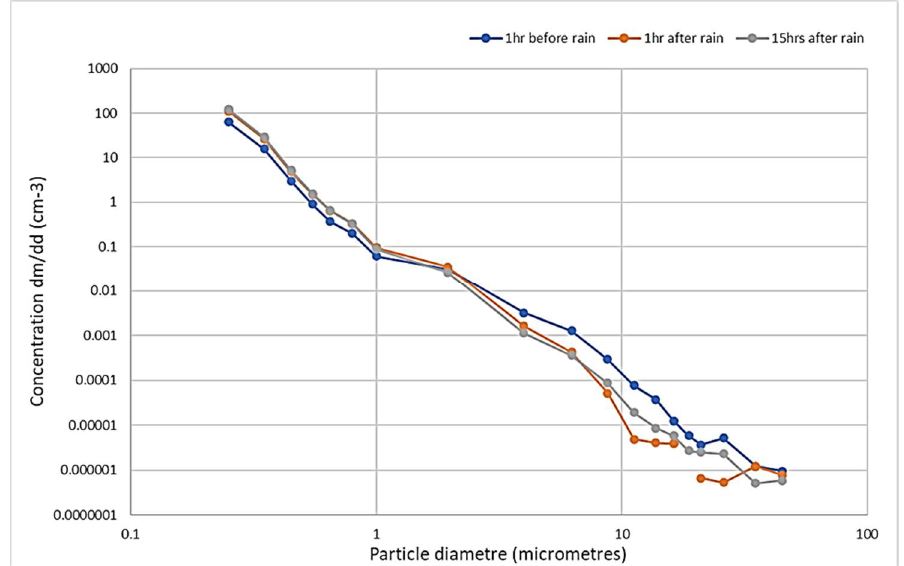
Figure 5. Granulometric analysis 1 h before the rain event, 1 h after and 15 h after.